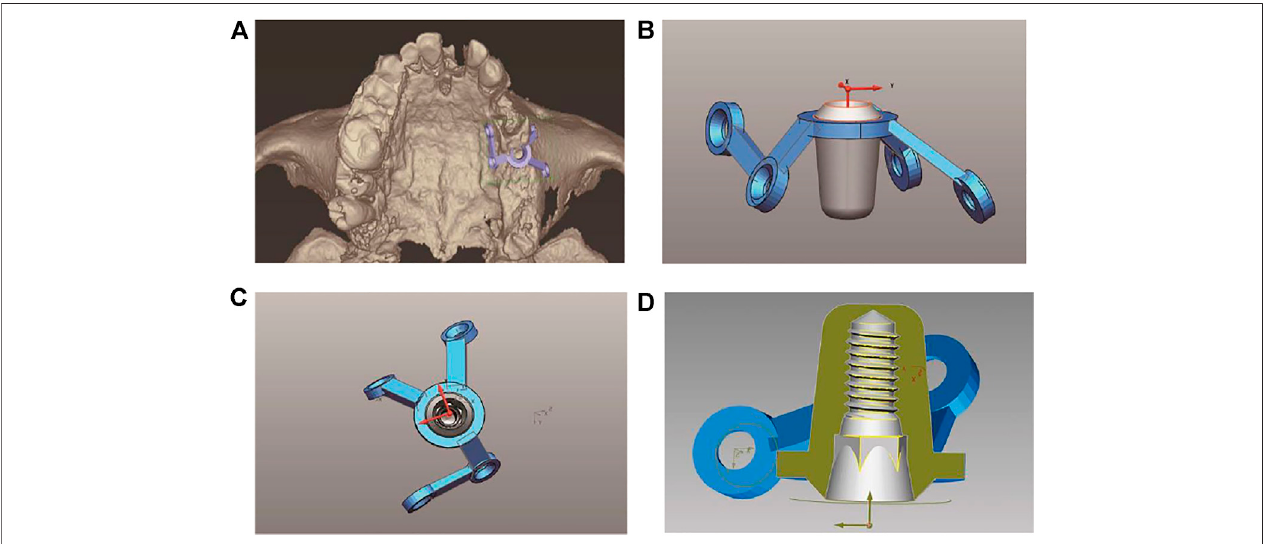
FIGURE 3 | Presurgical design. (A) The virtual model of the custom-made implant and its position in the 3D modeling of the alveolar bone. (B) The side view of the virtual model of the custom-made implant. (C) The top view of the virtual model of the custom-made implant. (D) The internal view of the virtual model of the custom- made implant.